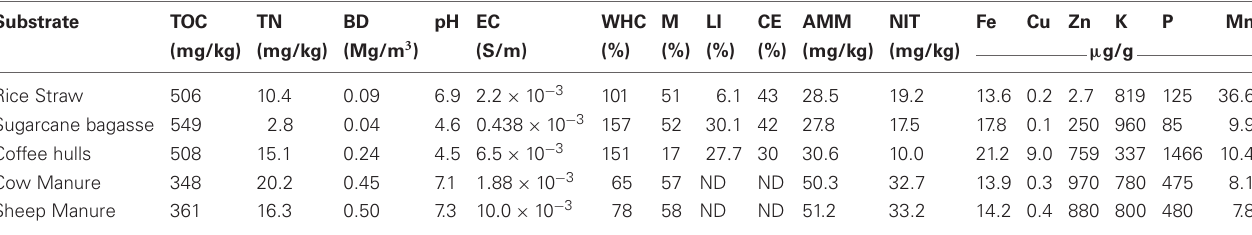
Table 1 | Selected physico-chemical characteristics of substrates used in compost construction a .